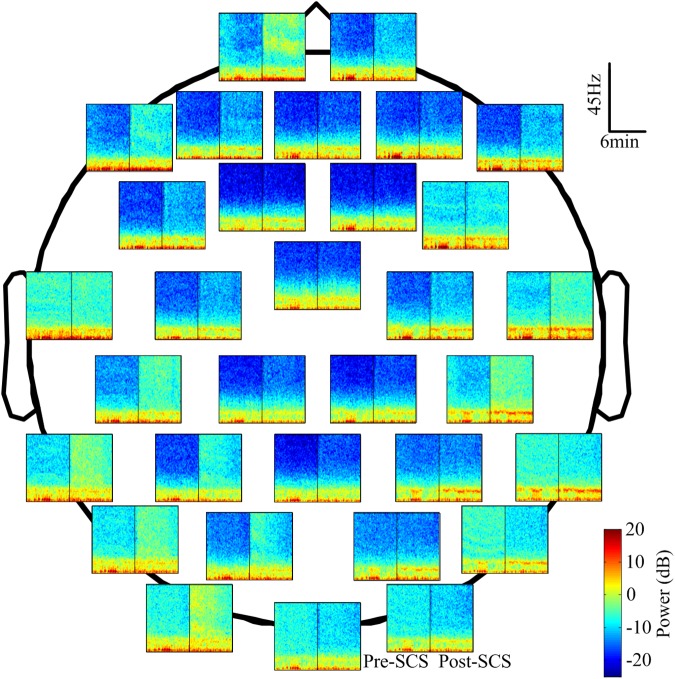
The power spectrum of 32 channels in the corresponding position of one participant (No. 1 in Table 1). The spectrum was computed with the short-time Fourier transform with a Hamming window. The blue represents the lower power and the dark red represents the higher power. The black line in each spectrum block represents the interposition of the SCS.